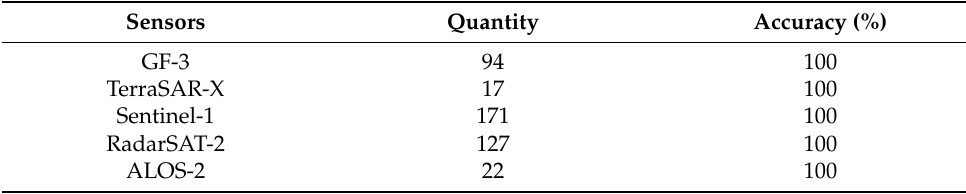
Table 2. Quantity and accuracy of selected homogeneous regions. Sensors